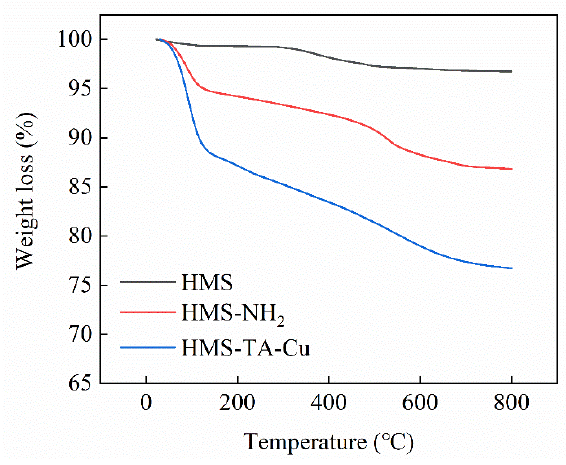
Figure 4. TGA curves of HMS, HMS-NH 2 and HMS-TA-Cu.